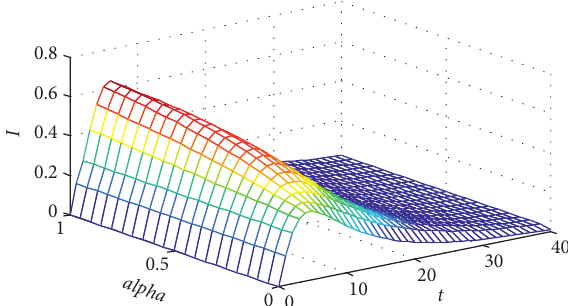
Figure 11: The interaction relation of infection density I and the coefficient of latent transformation α and t (this is helpful to analyze the relationship among ( I ) α and t ).